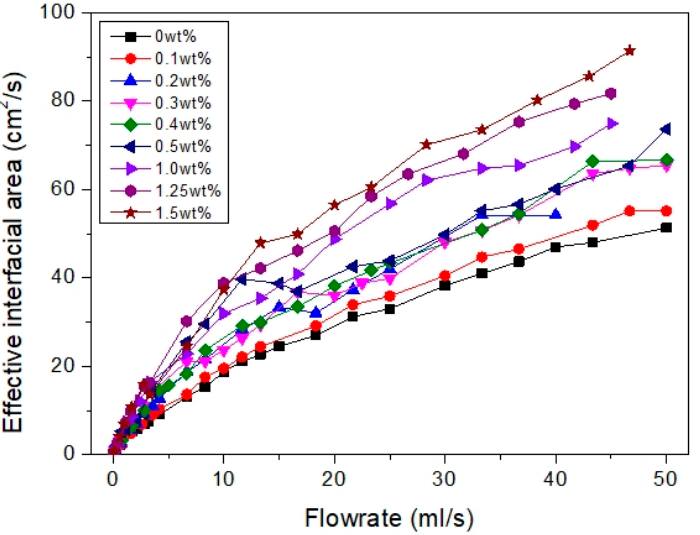
Figure 10. Effective air–liquid interfacial area at different PEBAX concentration under different air flow rates.